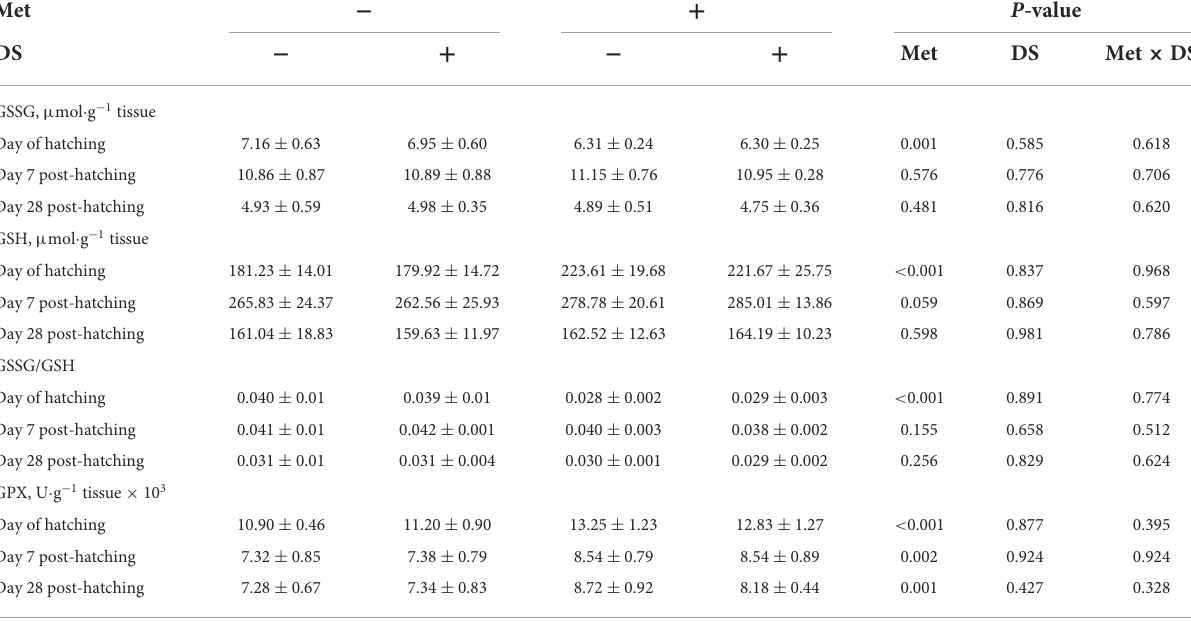
TABLE 11 Effects of in ovo injection of methionine (Met) and disaccharide (DS) on jejunum antioxidant parameters of geese during the early-life post-hatching a,b . Met −